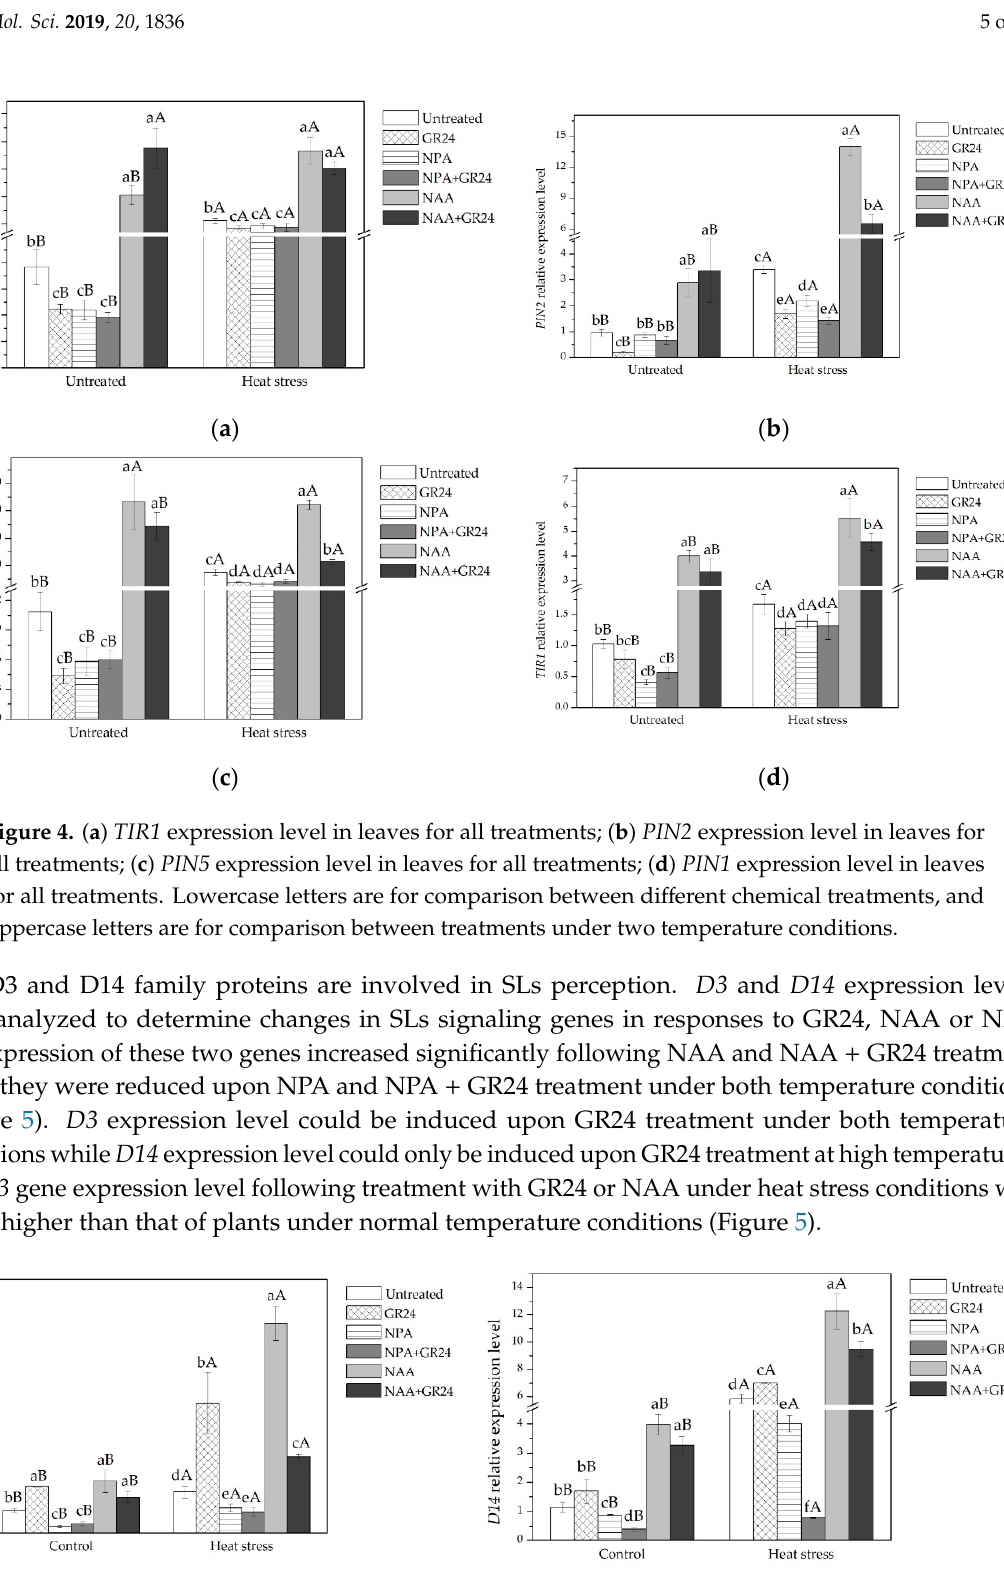
Figure 5. ( a ) D3 expression level in leaves for all treatments; ( b ) D14 expression level in leaves for all treatments. Lowercase letters are for comparison between different chemical treatments, and uppercase letters are for comparison between treatments under two temperature conditions.